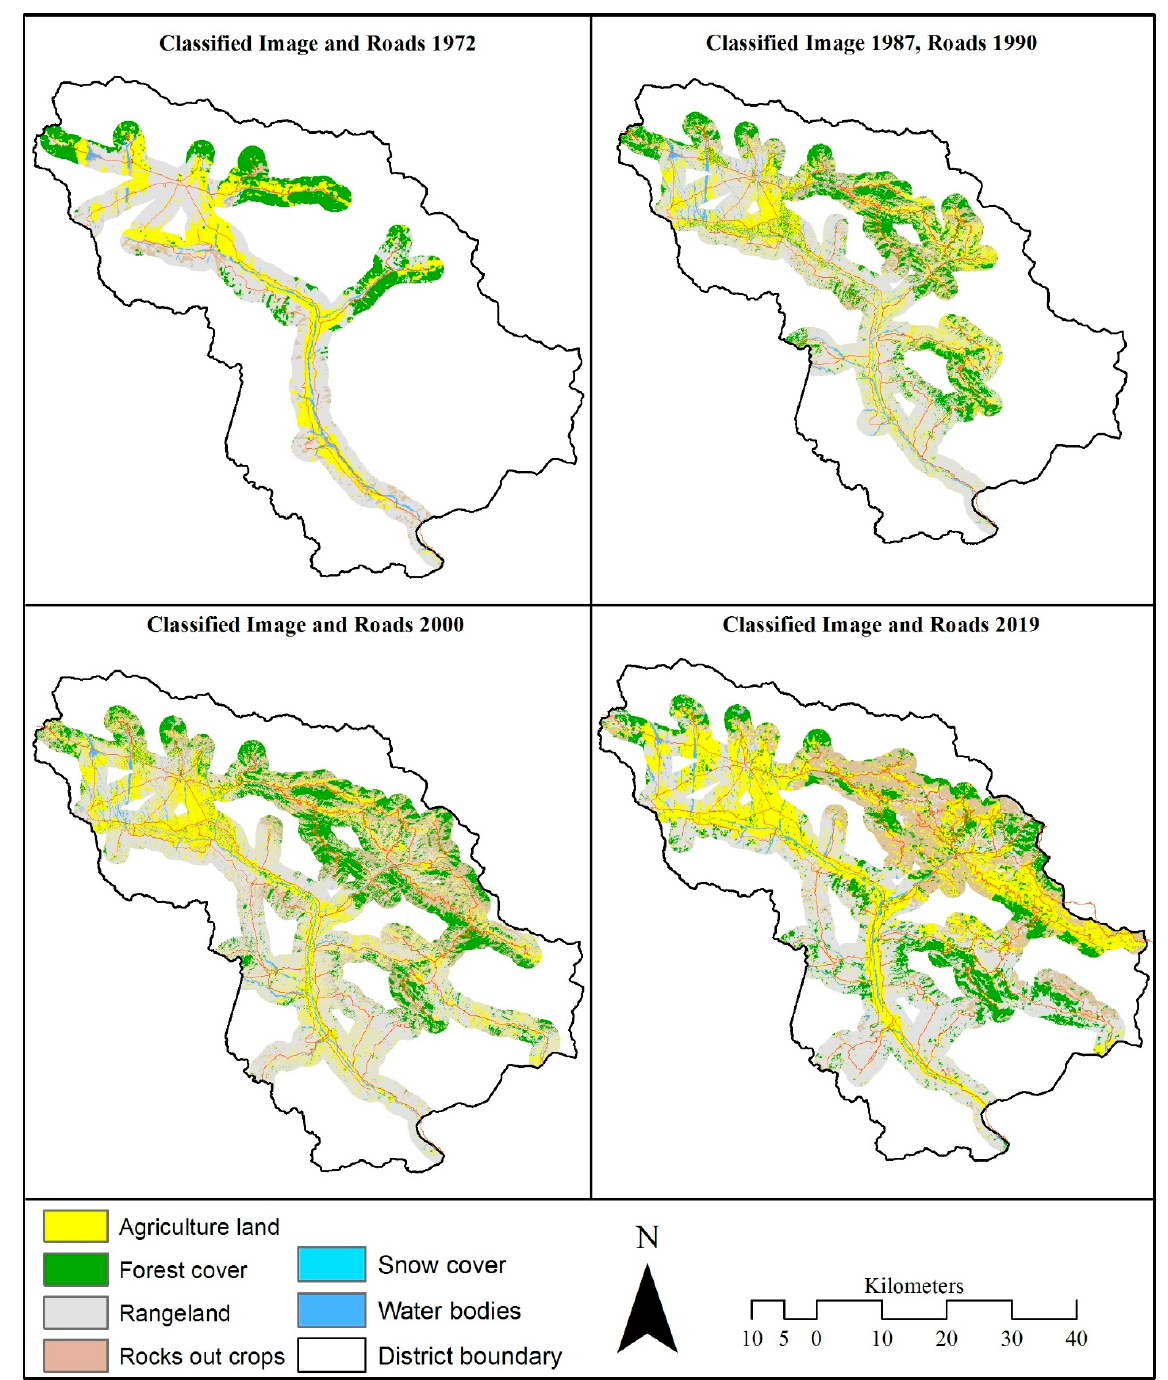
Figure 8. Land use and land cover within 2 km of roads from 1972 to 2019 .